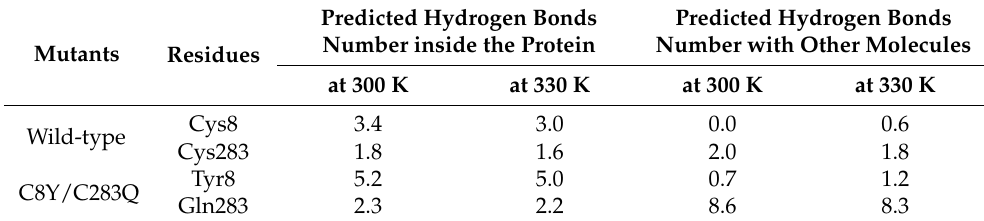
Table 5. Potential forming hydrogen bond numbers at mutated sites.